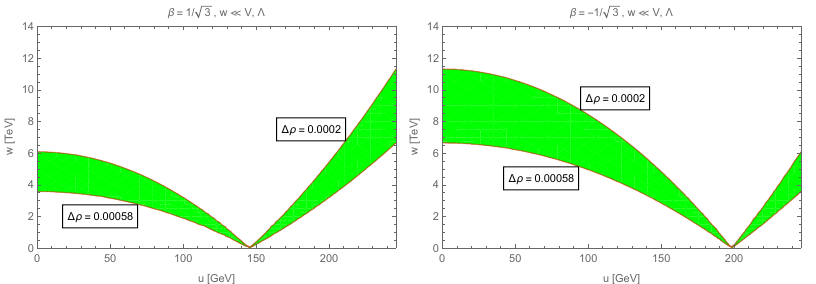
Figure 2 . The ( u, w ) regime that is bounded by the ρ parameter for w right panels correspond to β = 1 / √ 3 and β =